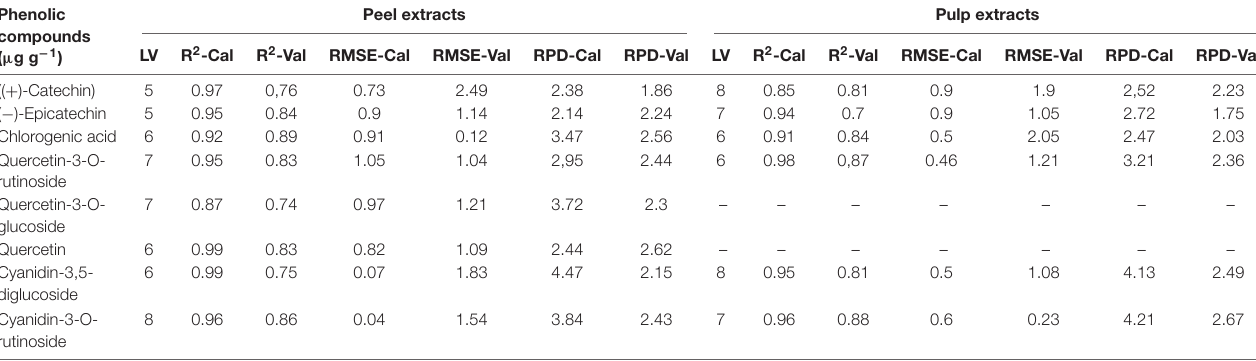
TABLE 3 | Calibration and cross-validation results of multivariate models developed by using attenuated total reflectance Fourier transform infrared (ATR-FTIR) spectra in the regions of 1,175–940 cm − 1 in both fig peel and pulp. Phenolic Peel extracts Pulp compounds ( µ g g − 1 )